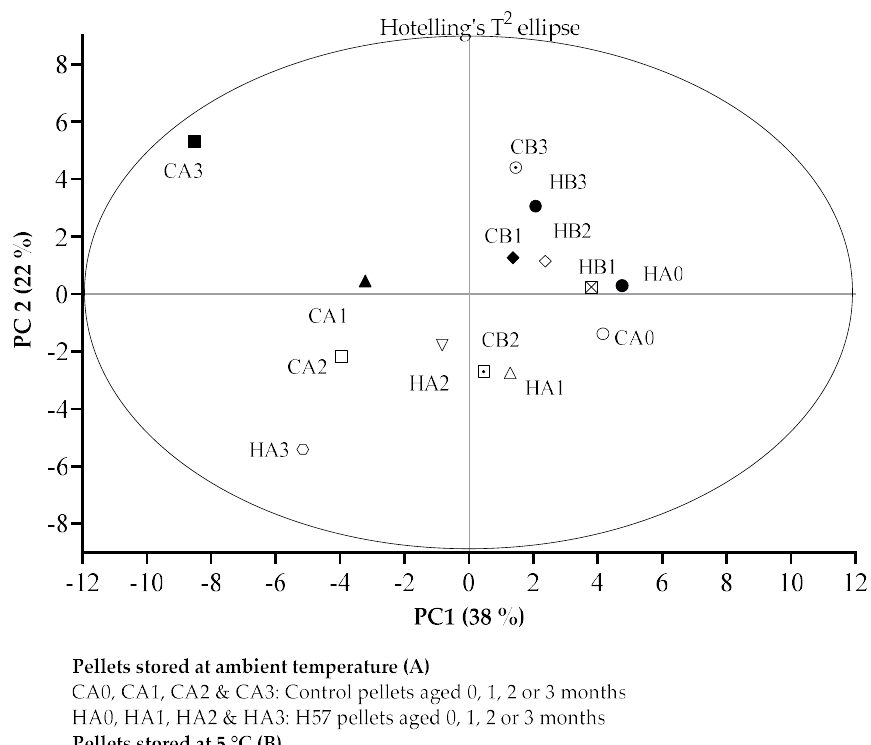
Figure 3. Distributions between the pellets treatments in a score plot of the PCA analysis. Hotelling’s T 2 ellipse indicated the outlier with critical test value at α = 0.05.